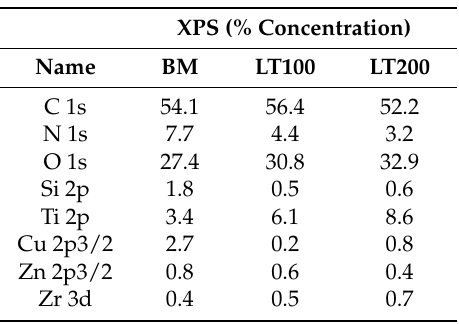
Table 1. Summary of % concentrations by XPS on untreated and laser treated surfaces.